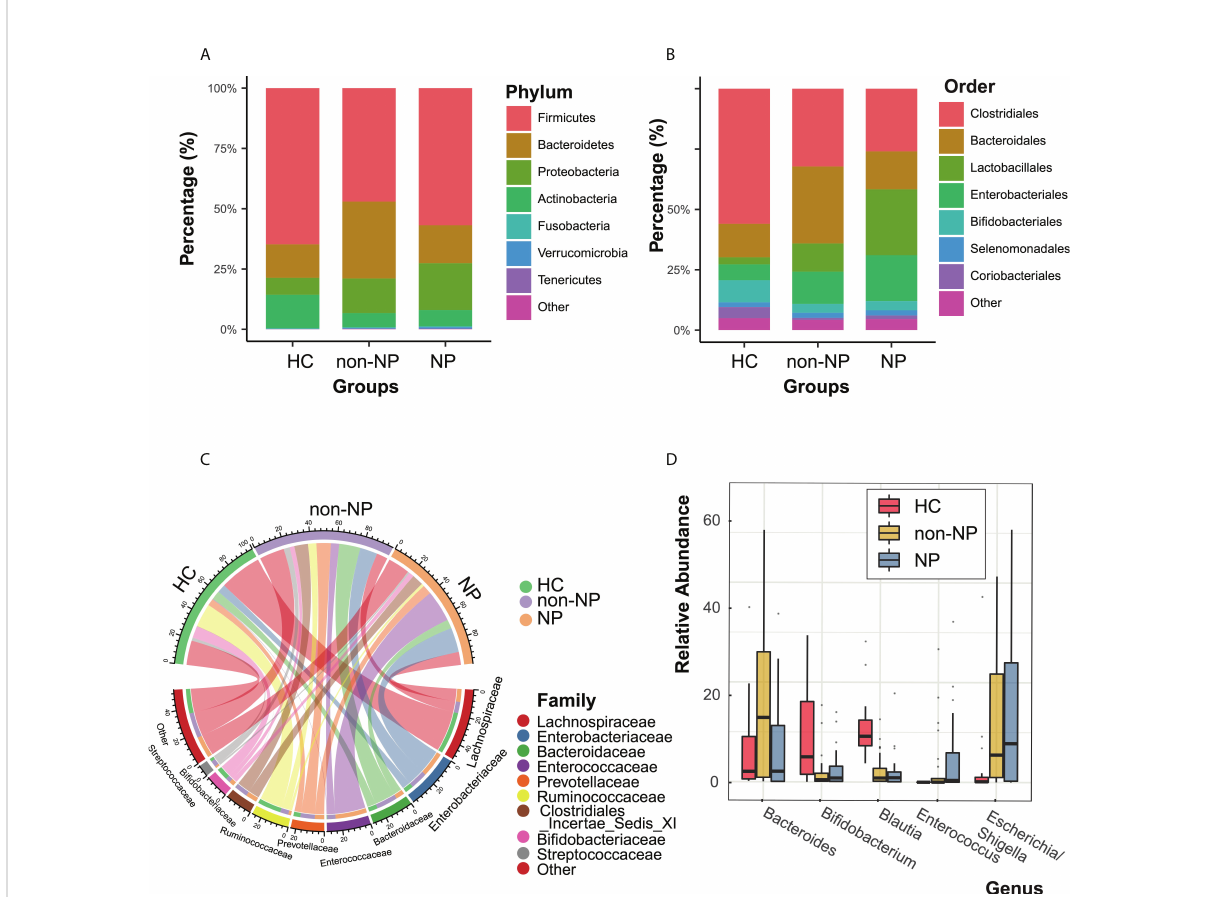
FIGURE 2 Taxonomic features of NP, non-NP and healthy control groups. Relative abundances of bacteria between groups at the phylum (A) , order (B) , family (C) and genus (D) levels. NP, necrotizing pancreatitis; non-NP, non-necrotizing